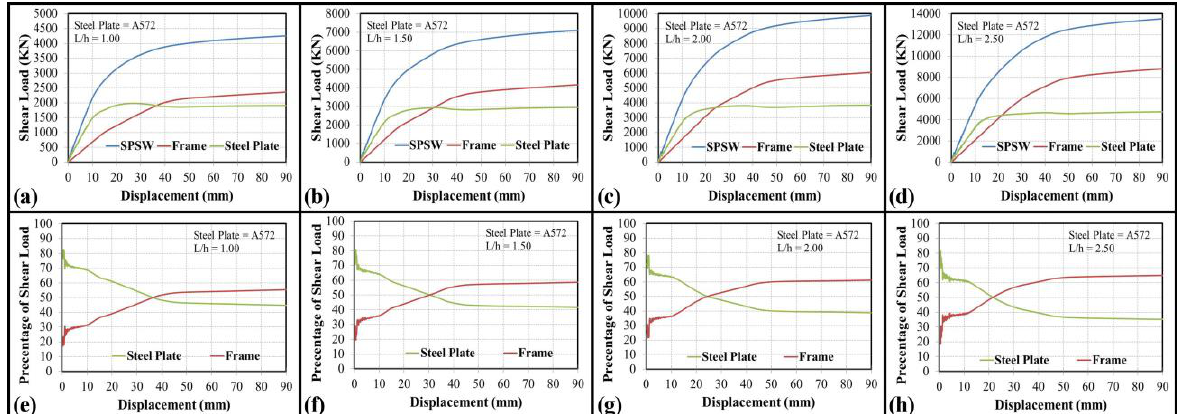
Fig. 9 . “Shear load-story drift” and “wall-frame interaction” curves of all SPSWs and moment frame using high- strength infill plate with different spans (3m, 4.5m, 6m, and